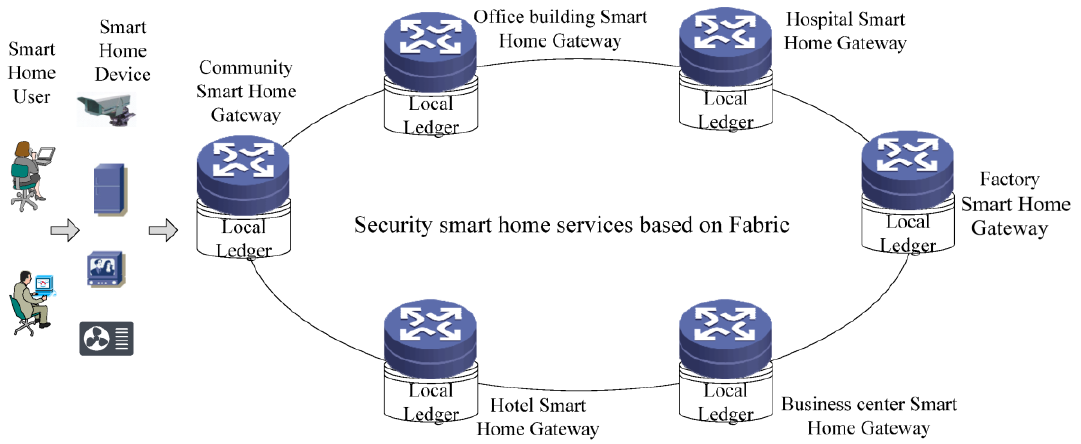
Figure 5. The network model of smart home security control services based on Fabric.